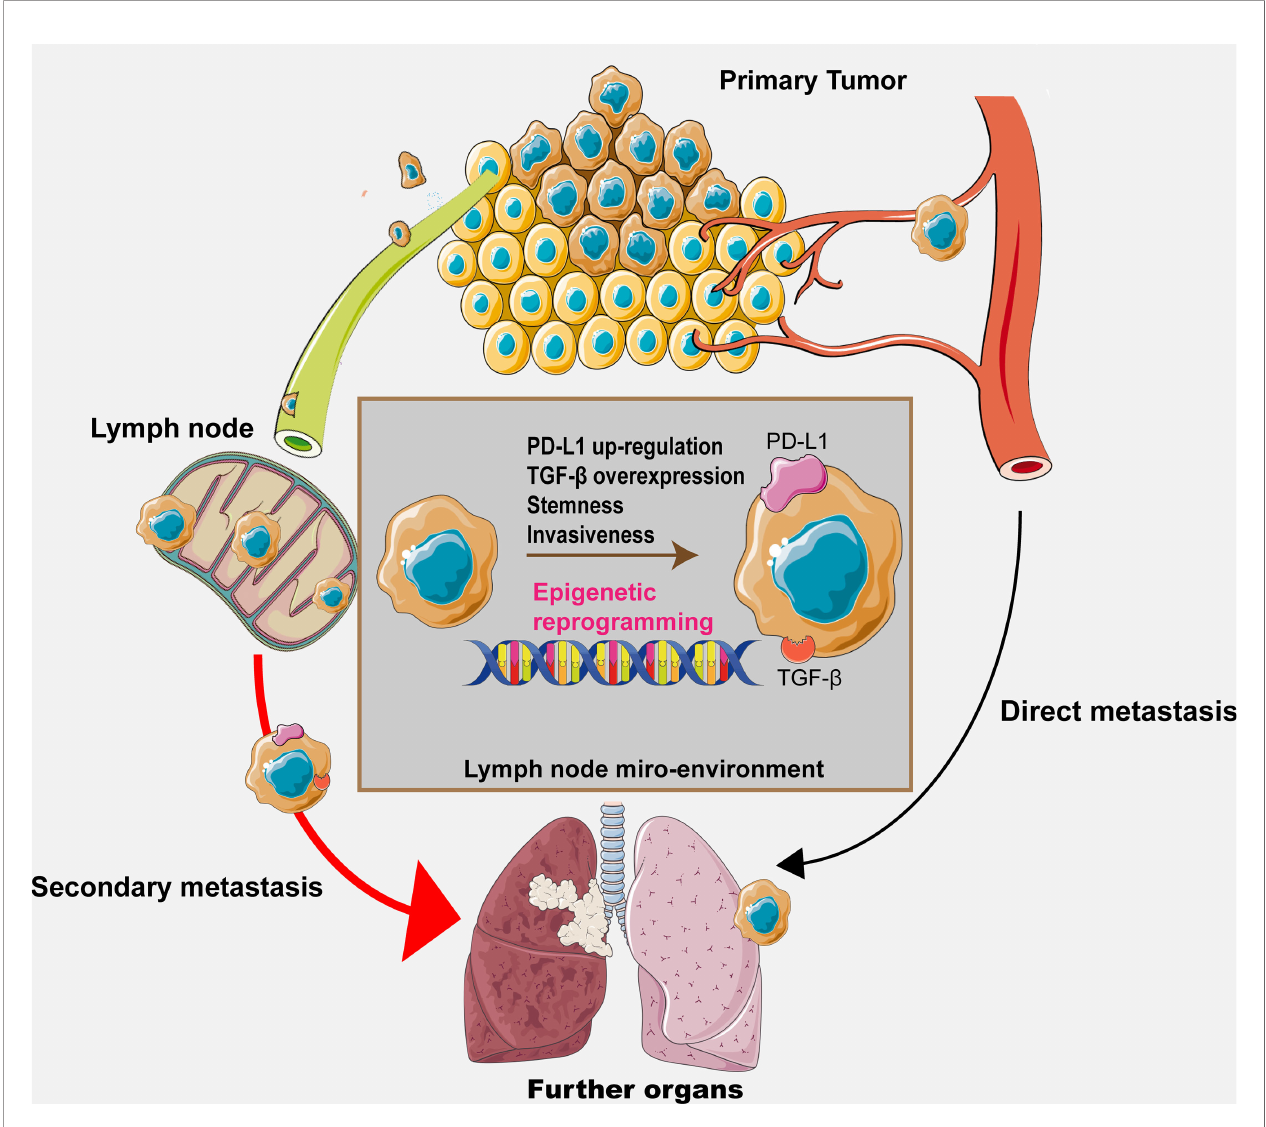
FIGURE 2 | The graphical hypothesis illustrating the regulatory process and potential mechanism throughout the metastasis